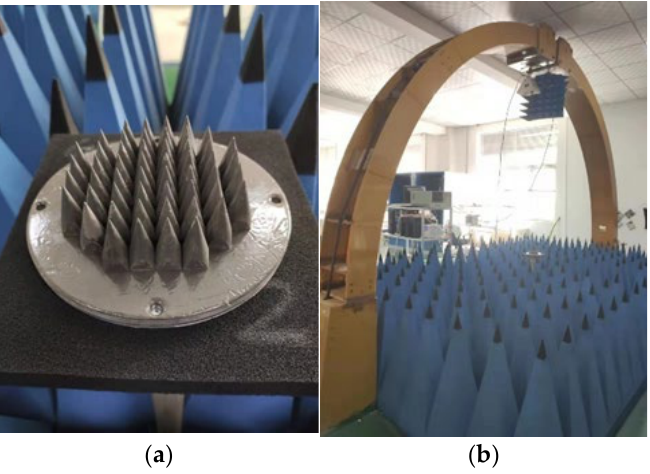
Figure 17. The practical testing scene. ( a ) Tested target; ( b ) Arch test system.